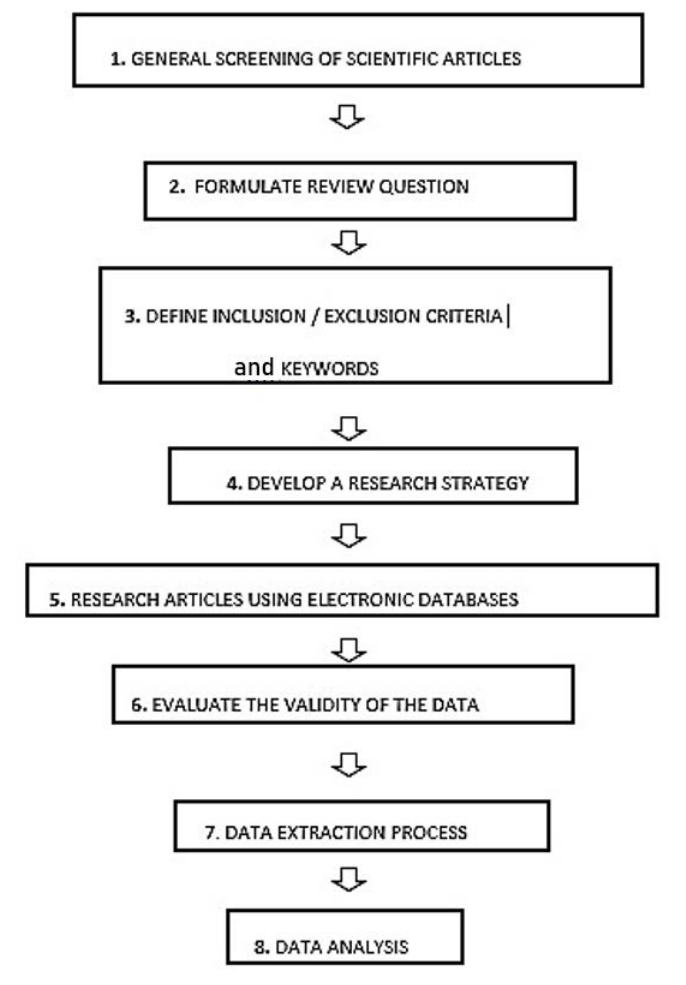
Figure 2. Different stages to carry out the systematic review: (1) general screening; (2) formulation of the review question; (3) definition of the inclusion and exclusion criteria and the keywords; (4) development of a research strategy; (5) research of articles using electronic databases; (6) evaluation of the validity; (7) extraction of the data; and (8) analysis of the